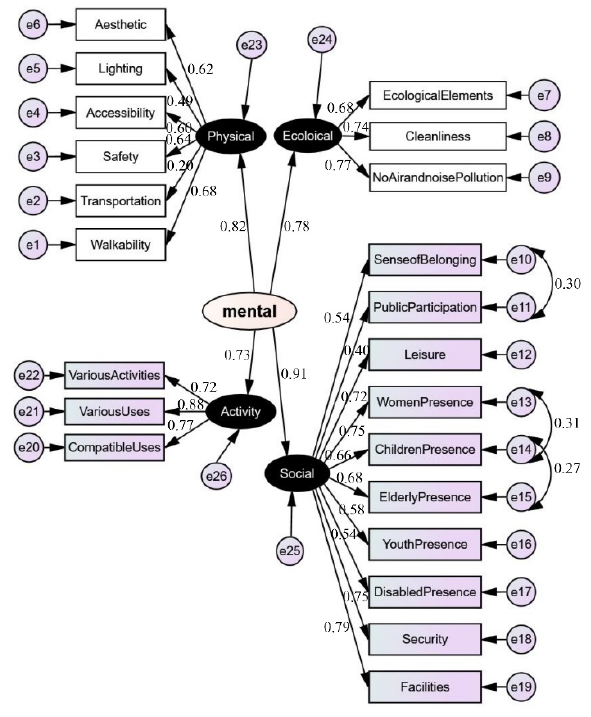
Figure 4. The developed framework of the study indicating the association of environmental quality characteristics of public open spaces related to users’ mental well-being. The results show that the model fit is appropriate (Table 6). The p -value indicates the weak value that can be explained by the chi-square sensitivity of the sample size. The parameters such as Root Mean Square Error of Approximation (RMSEA) (0.07), Fit Test of Chi-Square (3.32), Consistent Akaike Information Criterion (CAIC) (default model < saturated model), Standardized Root Mean Square Residual (SRMR) (0.06), Root Mean Square Residual (RMR) (0.06), Comparative Fit Index (CFI) (0.9), and Incremental Fit In- dex (IFI) (0.9) are in a good range. Other parameters show moderate fit. Table 6. Intervals of the goodness-of-fit indices for the SEM model and the goodness-of-fit values related to path analysis.